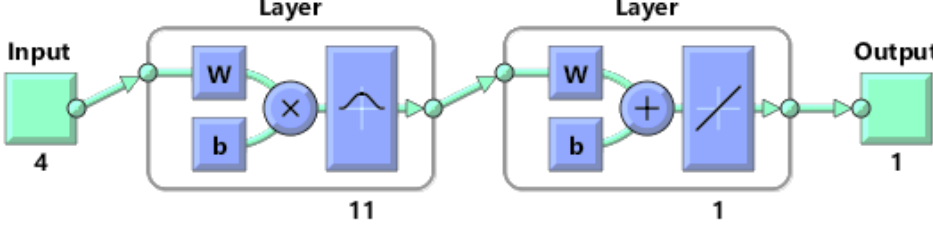
Figure 5. Schematic for the optimized RBF neural network.